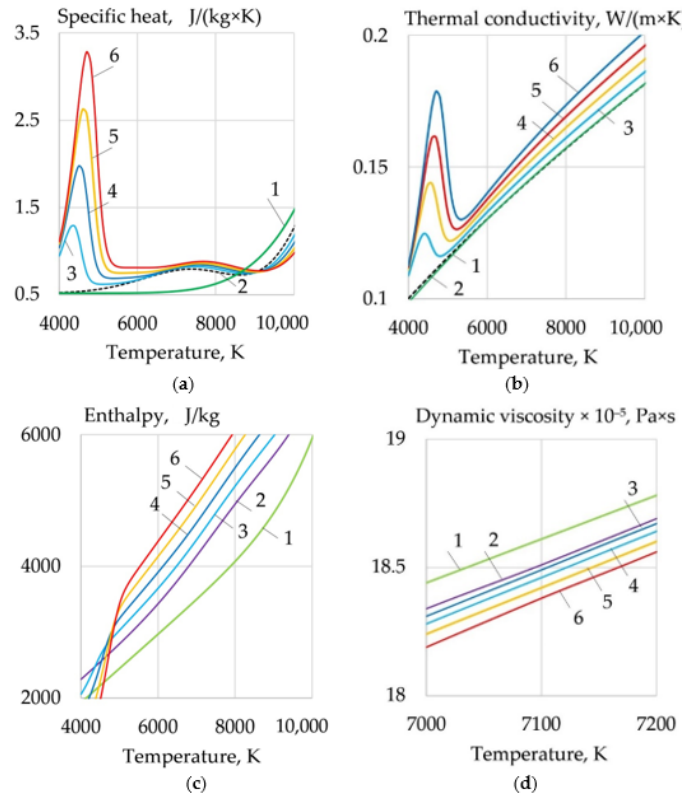
Figure 6. Change in specific heat ( a ), thermal conductivity ( b ), enthalpy ( c ), and dynamic viscosity ( d ) of an equilibrium system at 0.1 MPa, wt.%: (1) 100 Ar; (2) 95Ar + 5Fe: (3) 90Ar + 5Fe + 5LaF 3 ; (4) 85Ar + 5Fe + 10LaF 3 ; (5) 80Ar + 5Fe + 15LaF 3 ; (6) 75Ar + 5Fe + 20LaF 3 . When LaF 3 is added, a significant increase in the specific heat and thermal conduc- tivity of the plasma occurs at the arc boundary at temperatures of 4000–5000 K, in the zone of molecular dissociation reactions. The addition of LaB 6 increases the specific heat, ther- mal conductivity and enthalpy of plasma at temperatures of 6000–10,000 K and reduces the dynamic viscosity of the plasma, as shown in Figure 7.